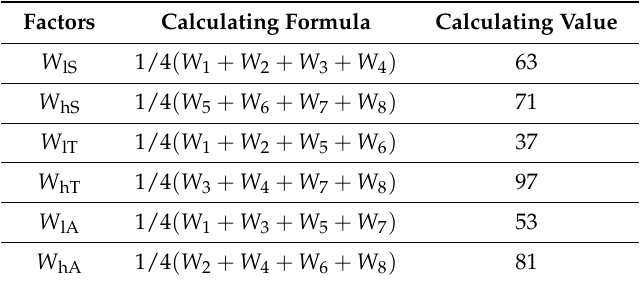
Table 5. Average e ff ects of the factors for each